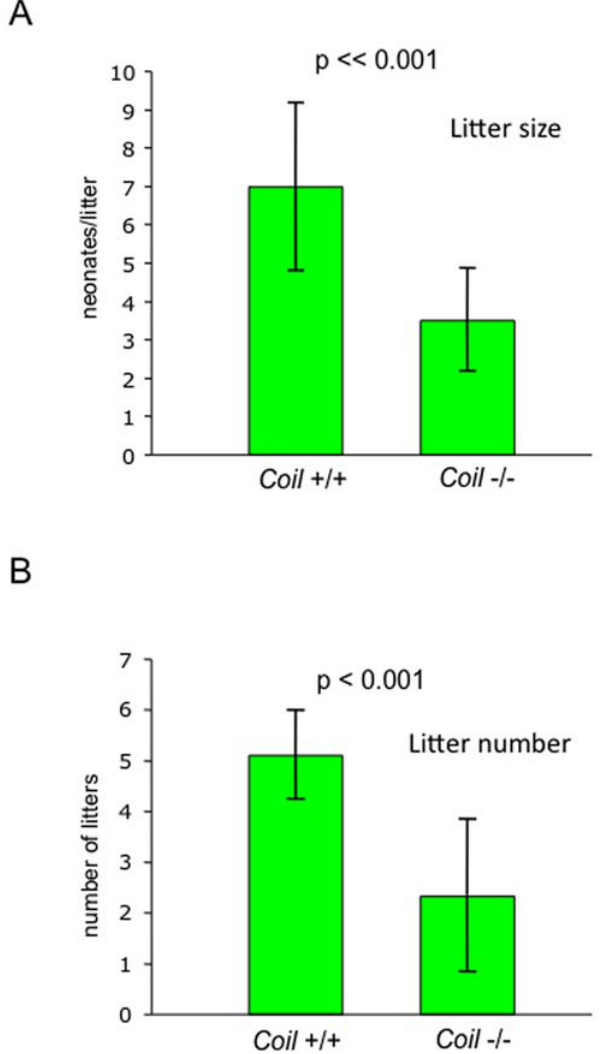
Figure 1. Coil 2 / 2 mice are reproductively less fit. The mean litter size (A), and the mean number of litters (B) were analyzed during a 6- month course of breeding. Coil 2 / 2 mice displayed reduced litter size and litter number compared to Coil + / + controls, p =2 6 10 2 8 and p =3 6 10 2 7 , respectively. P values were calculated by Student’s T-test